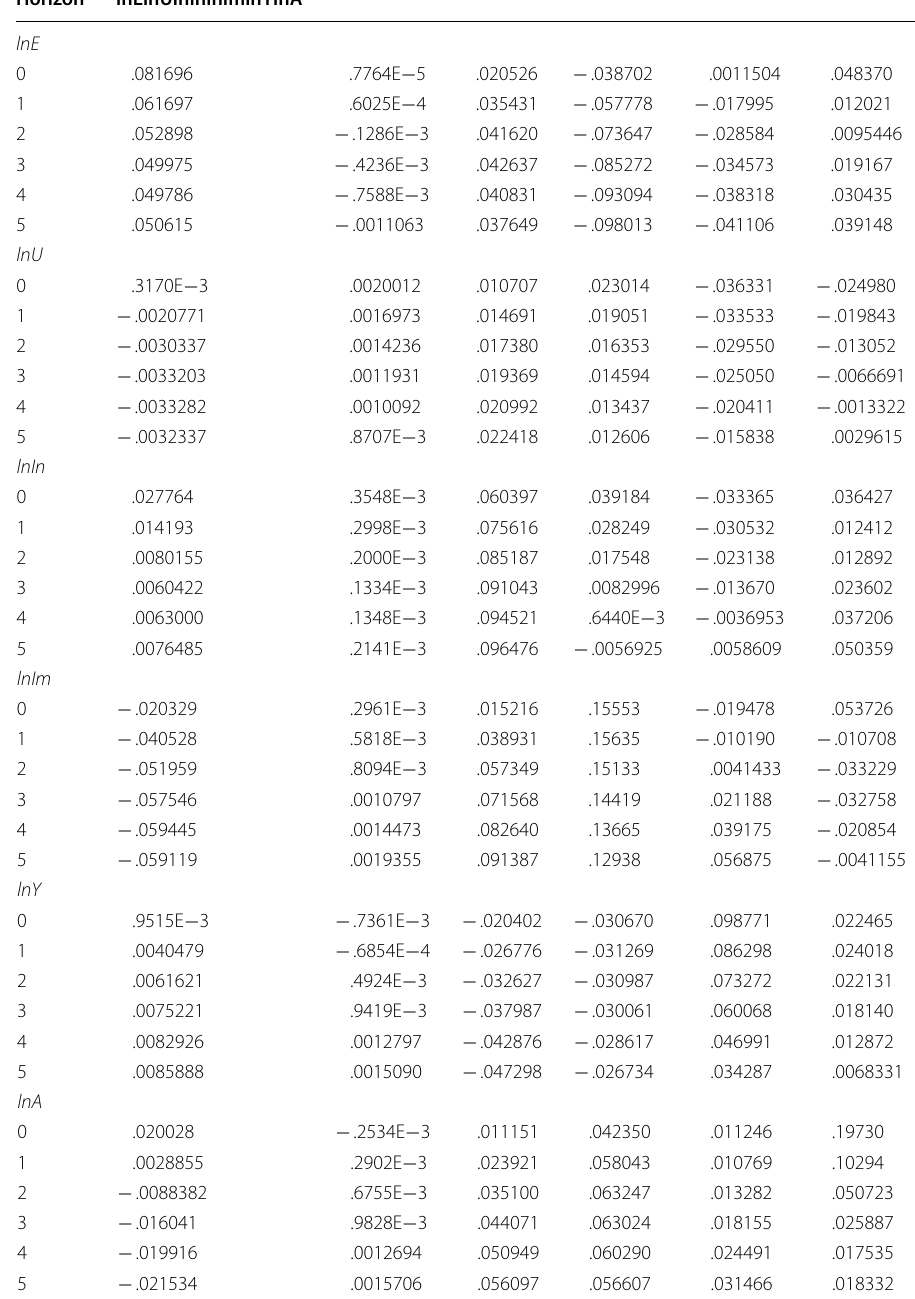
Table 8 Generalized impulse responses to one SE shock in the equation for unrestricted vector autoregressive model